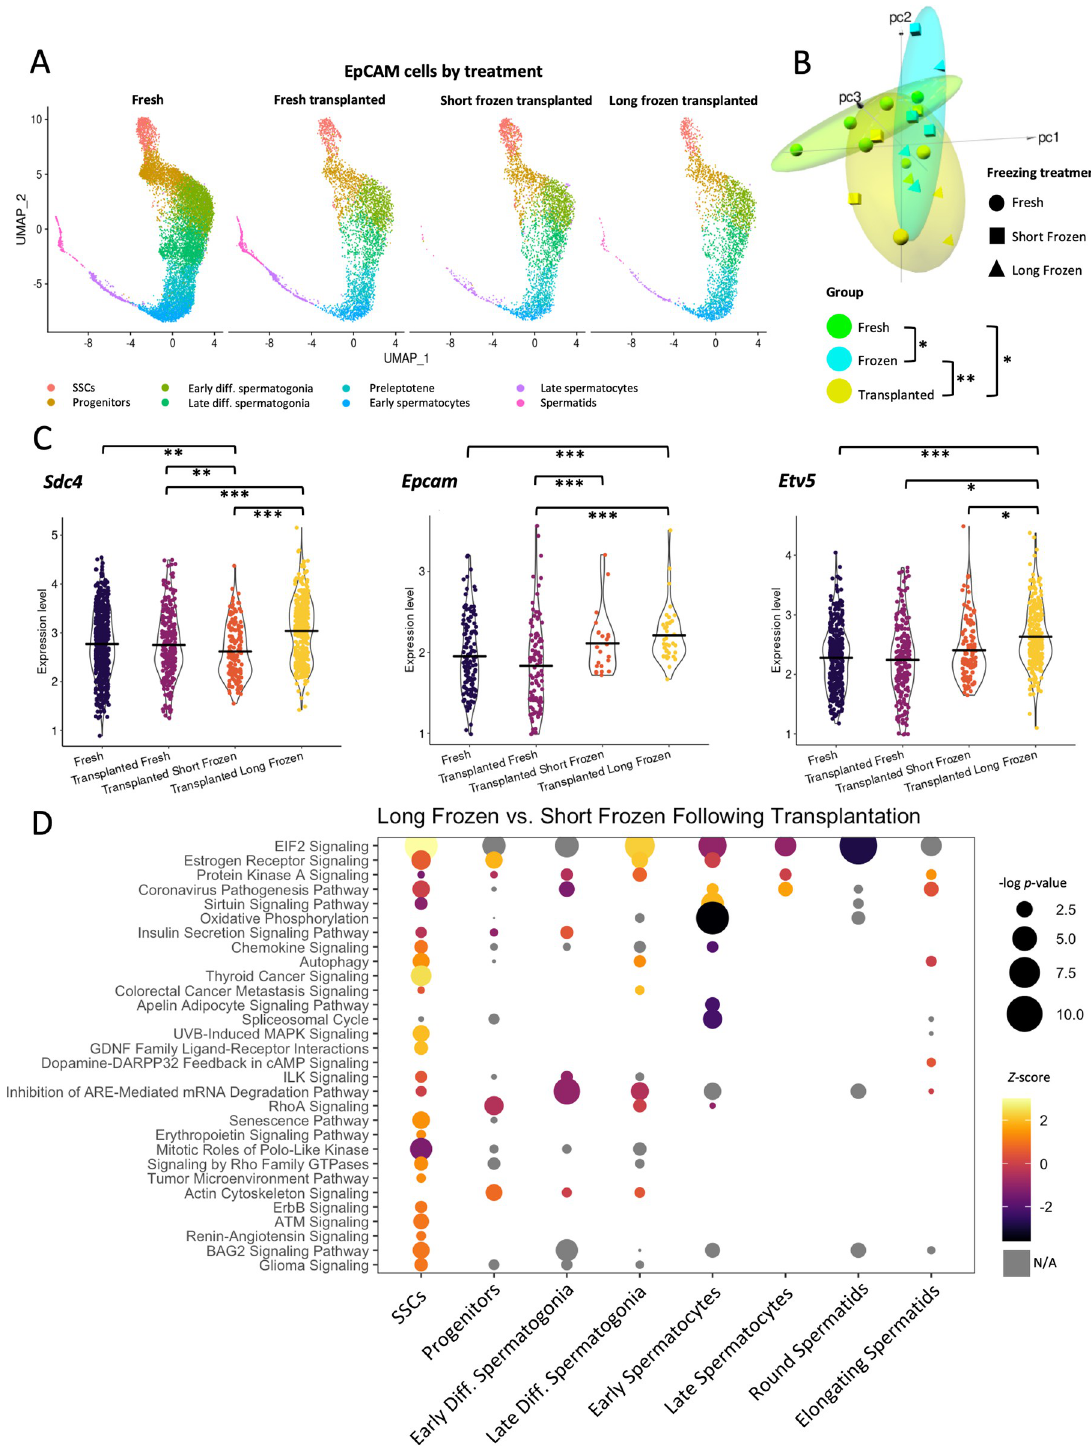
Fig 5. Transplanted colonies show enhanced activity of SSC genes within the stem cell compartment following long freezing treatment. (A) Distribution of EpCAM-selected cells from transplanted testes, split by treatments showing all cell type assignments. (B) PCA plots for SSCs generated from pseudobulk data for each replicate. 75% confidence intervals are shown for fresh, frozen, and transplanted groups. Significance assessed by PERMANOVA (1,000 permutations, treating short- and long-frozen thawed samples as one group and all transplanted samples as another, � p < 0.05, �� p < 0.01) (C) Expression by treatment for 3 genes that mark